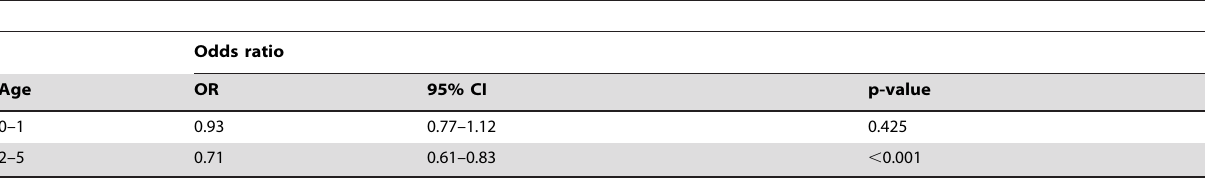
Table 5. Odds ratios of infection in children with TF in two specific age groups, with each round of